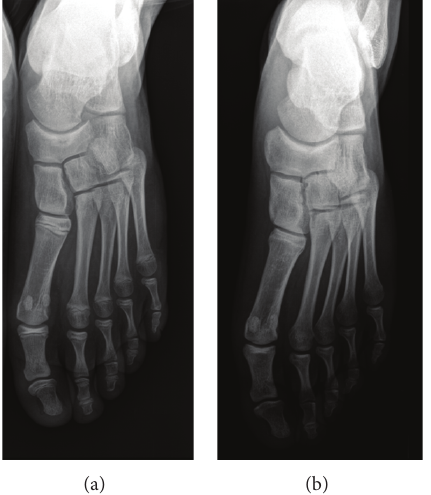
Figure 2: Radiographs of the left foot at 4-month (a) and 2-year (b) follow-up consultations, showing a favorable radiologic